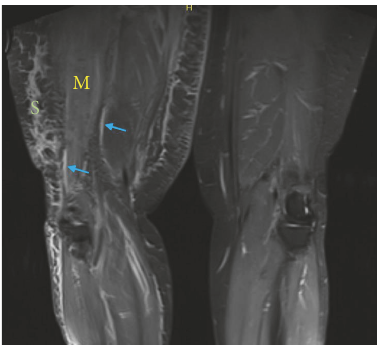
Figure 2: MRI leg without contrast. Right thigh musculature (M) and subcutaneous tissues (S) with diffuse swelling and edema-like signal on T1-weighted imaging. Fluid-like signal is noted at the fascial planes